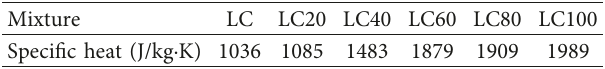
Table 7: Effect of SWM dosage on specific heat capacity of LC.